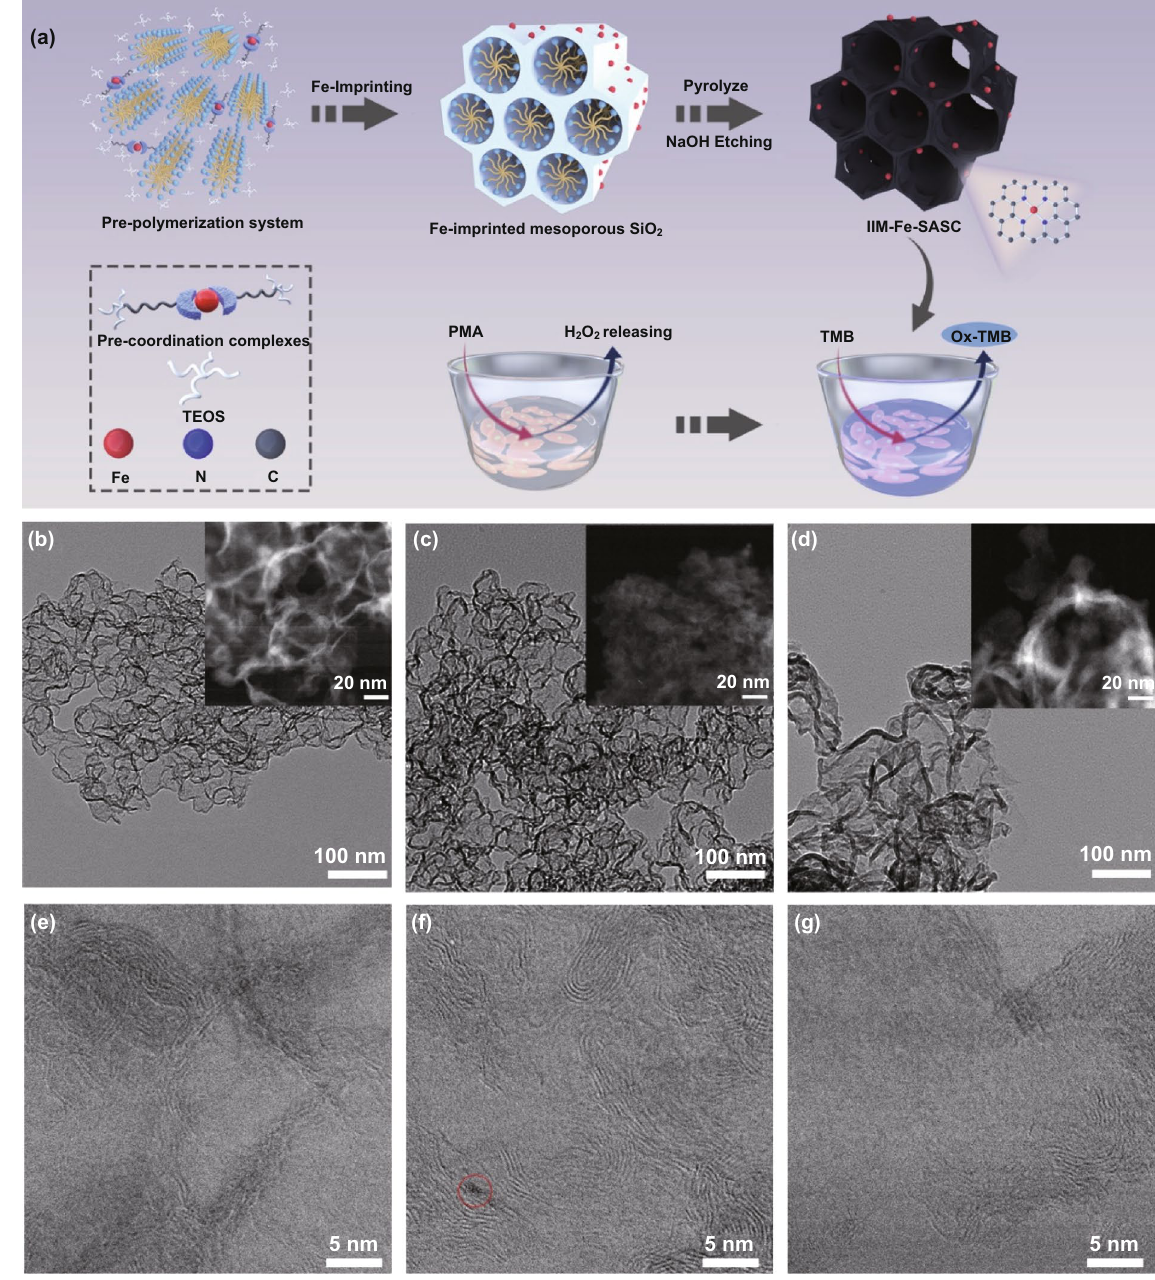
Fig. 1 a Schematic diagram of the process steps for IIM-Fe-SASC nanoprobe synthesis and in situ intracellular hydrogen peroxide detection. b–d TEM images of IIM-Fe-SASC, NIM-Fe-SASC, and NIM in different resolutions. e–g STEM bright-field images for IIM-Fe-SASC, NIM- Fe-SASC, and NIM at higher NaOH solution under vigorous stirring. 11 mg ion template